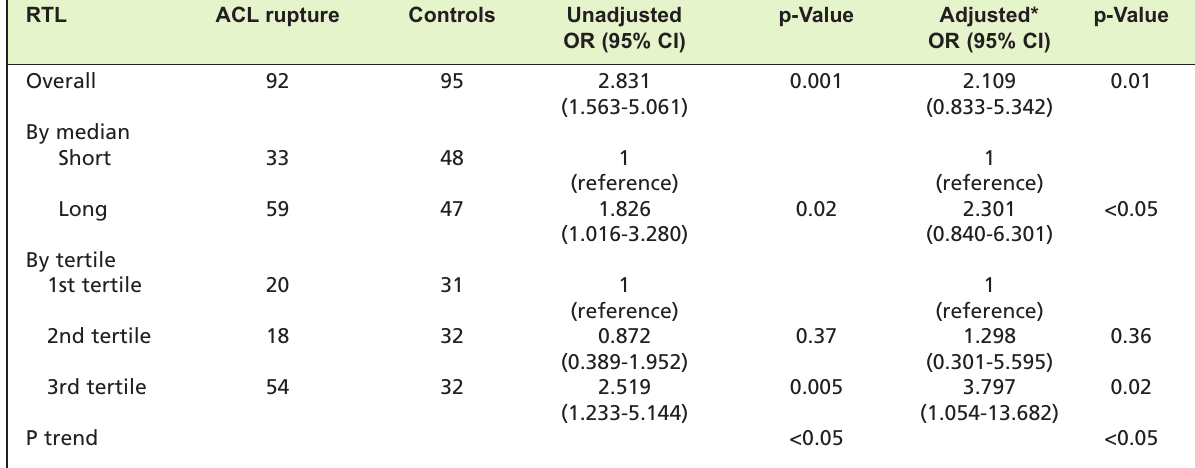
Logistic regression analysis of association between RTL and risk of ACL rupture Table II: